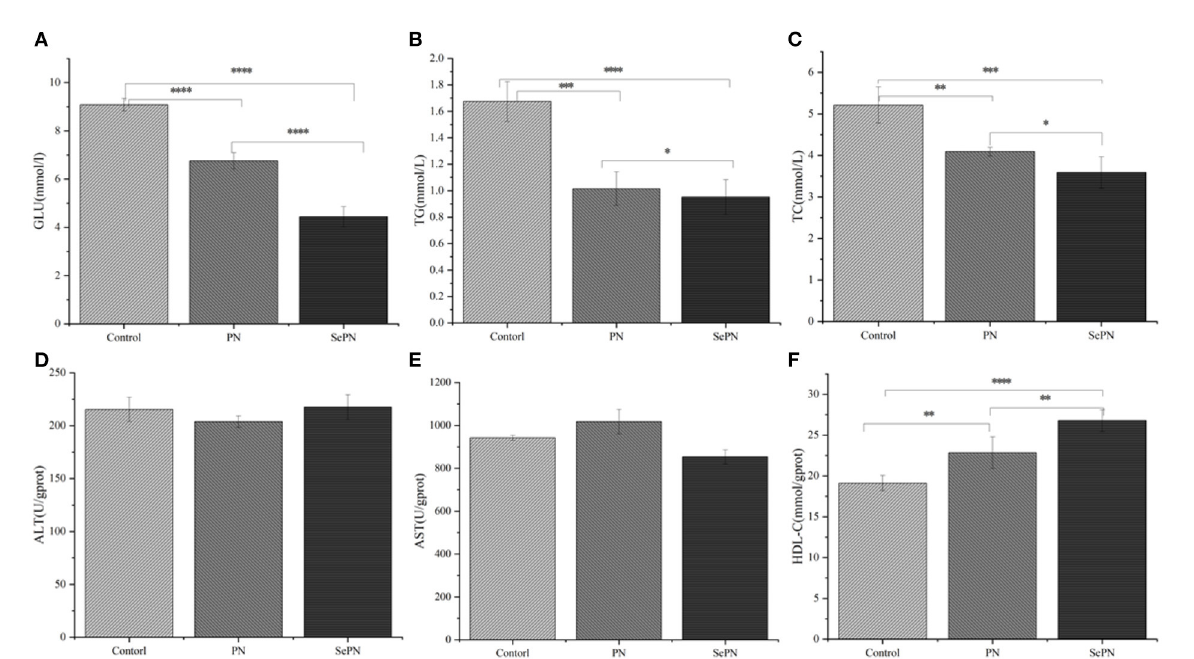
FIGURE2 Glucolipid metabolism physiological indexes in serum of mice. (A–C) . The content of glucose (GLU), triglyceride (TG), and total cholesterol (TC) in the serum. (D,E) . The level of alanine aminotransferase (ALT) and aspartate aminotransferase (AST). (F) . High-density lipoprotein cholesterol (HDL-C). Data are expressed as the mean ± SD. * P < 0.05, ** P < 0.01, *** P < 0.001, and **** P < 0.0001 compared with the control group ( n =